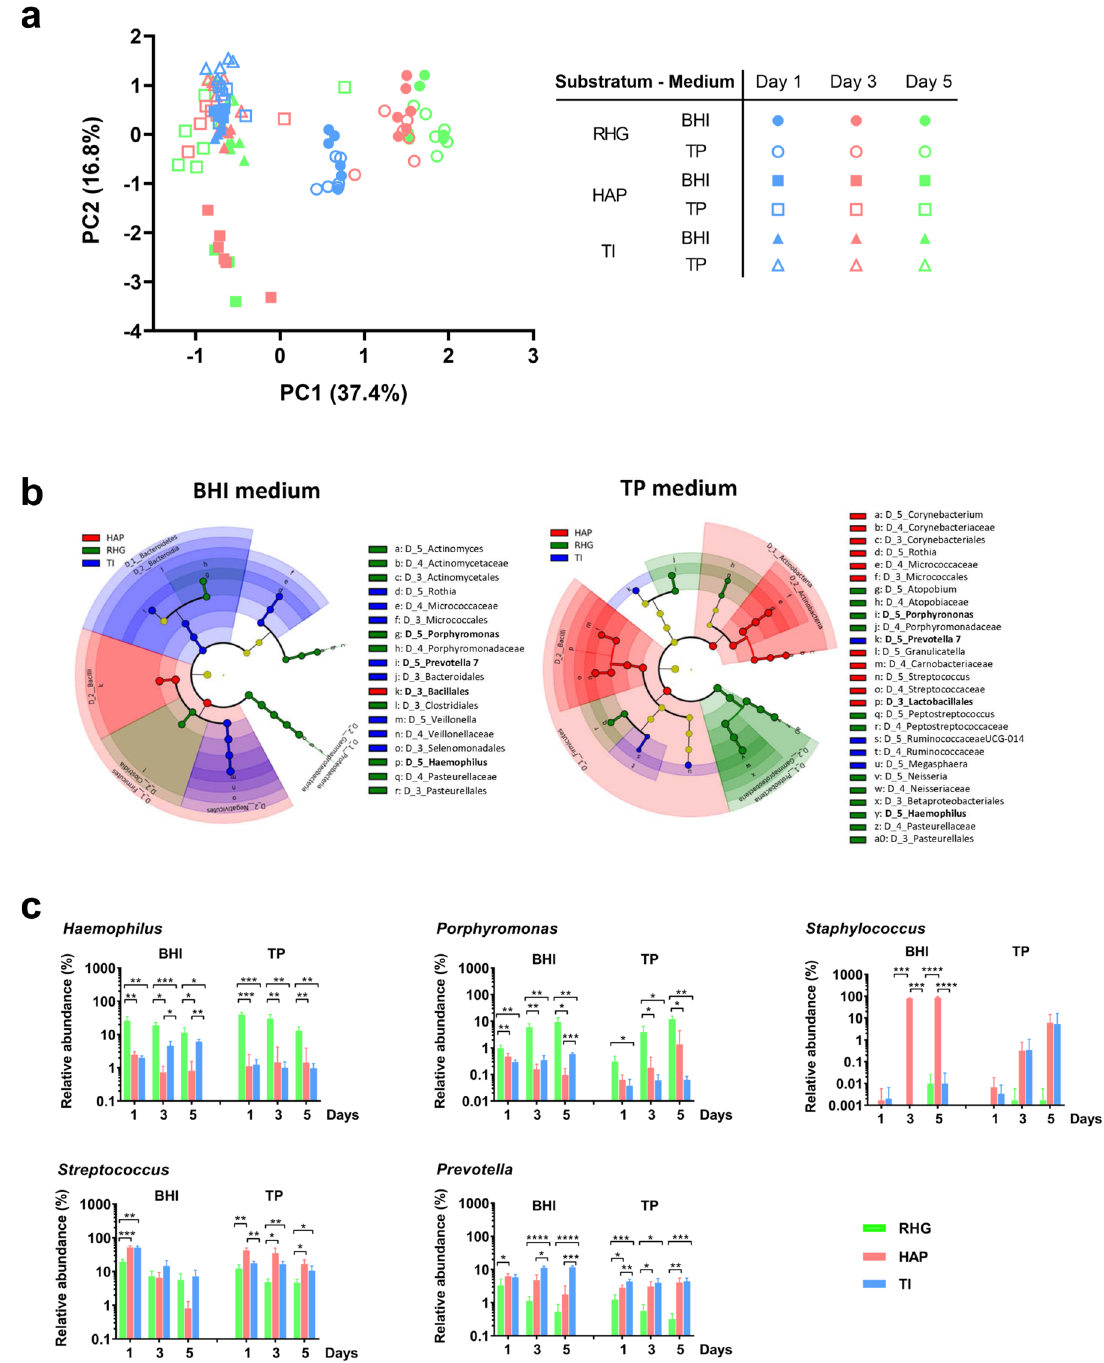
Fig. 3 Ordination of microcosm bio fi lms grown under different conditions. a Principal component analysis (PCA) plot of microcosm bio fi lms grown in BHI or TP and on different substratum (RHG, HAP or TI) over time (day 1, 3 or 5). b Cladogram represents the differentially abundant orders, families and genera in the bio fi lms grown on the surfaces of RHG, HAP and TI when the growth medium was BHI or TP. The root denotes the domain bacteria. The taxonomic level of class is labeled, while order, family and genus are abbreviated. The color shade indicates the abundance of substratum-speci fi c taxa. The size of each node represents their relative abundance. The cladogram was plotted based on the logarithmic LDA score calculated in LEfSe with an effect size cutoff of 4.0. The bacterial genera or higher level appeared in both BHI and TP medium on the same substratum are in bold. c The relative abundance (%) of individual bacterial genera in microcosm bio fi lms grown on the surfaces of RHG, HAP and TI. The substratum-speci fi c individual bacterial genera (or higher level) were selected based on the results shown in the cladogram: Haemophilus and Porphyromonas for RHG-bio fi lms; the class Bacilli for HAP-bio fi lm and Prevotella for TI- bio fi lms. The relative abundances of Staphylococcus and Streptococcus , representatives of Bacillales and Lactobacillales , are shown. Data are shown as mean ± standard deviation. The * represents statistically signi fi cant difference ( p < 0.05) compared using two-way ANOVA with Bonferroni ’ s multiple comparisons test in Prism 8 version 8.2.1. RHG: Reconstructed Human Gingiva; HAP: hydroxyapatite discs; TI: titanium discs. TP: Thompson medium. Data represent the average of 3 independent experiments, each performed in